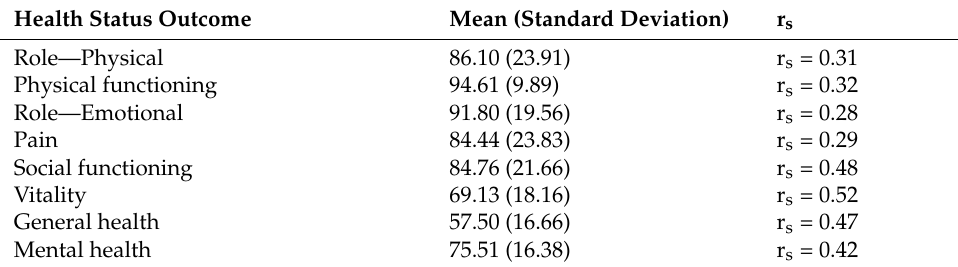
Table 3. Correlations between the CSPS ‐ 6 and the health status.